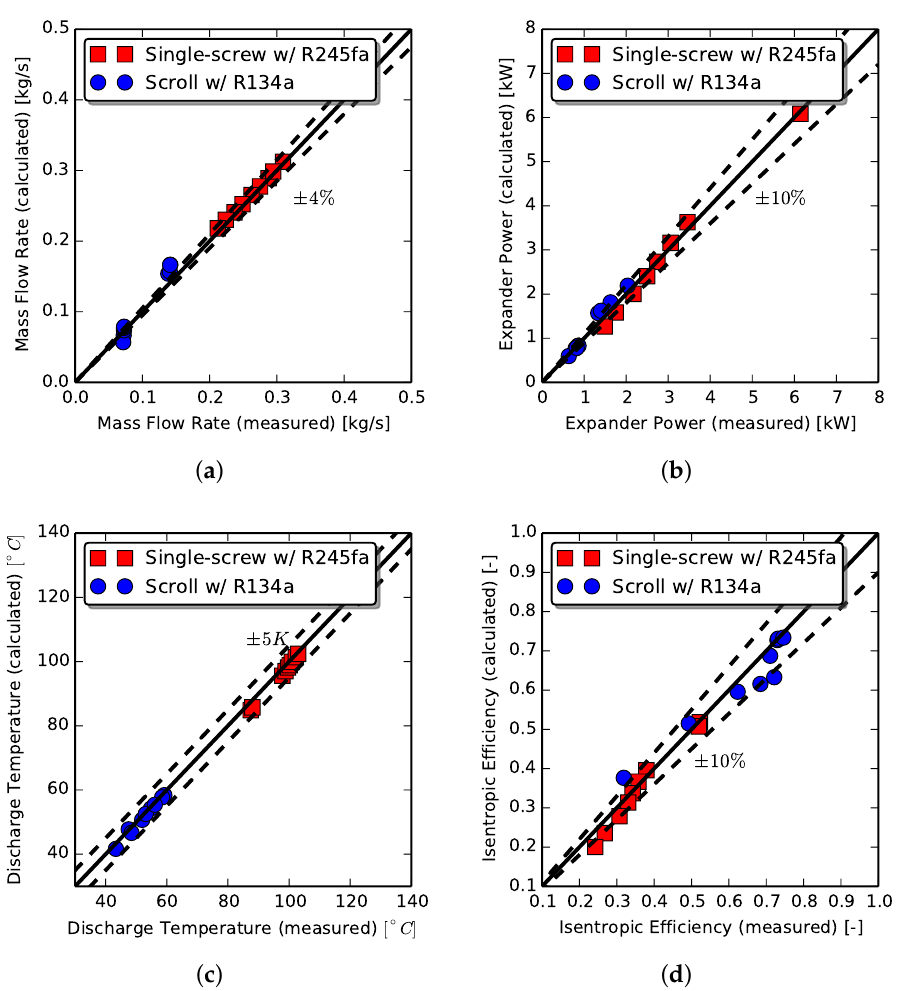
Figure 13. Comparison between measured and predicted values with the semi-empirical model for the scroll and single-screw expanders: ( a ) refrigerant mass flow rate; ( b ) power output; ( c ) discharge temperature; ( d ) isentropic efficiency. In the parity plots, 20 steady-state points are shown. In the case of the scroll expander, the steady-state points have been obtained for a total refrigerant charge of 25 kg (55.13 lb) and different rotational speeds, while for the single-screw expander only the rotational speed of 3000 rpm has been chosen. A comprehensive validation of the single-screw expander can be found in [22]. ( a ) Mass flow rate: MAPE(R245fa) = 1.48%; MAPE(R134a) = 6.31%; ( b ) Power output: MAPE(R245fa) = 5.11%; MAPE(R134a) = 8.25%; ( c ) Discharge temperature: MAPE(R245fa) = 0.42%; MAPE(R134a) = 0.28%; ( d ) Isentropic efficiency: MAPE(R245fa) = 6.14%; MAPE(R134a) =